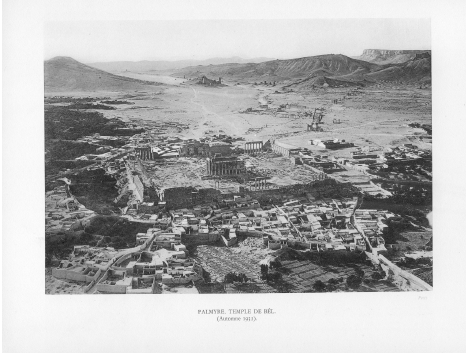
Figure 18. The ruins of Palmyra photographed from the air. In the middle the Temple of Bel surrounded by a large and walled temenos. Photo: A. Poidebard 1932